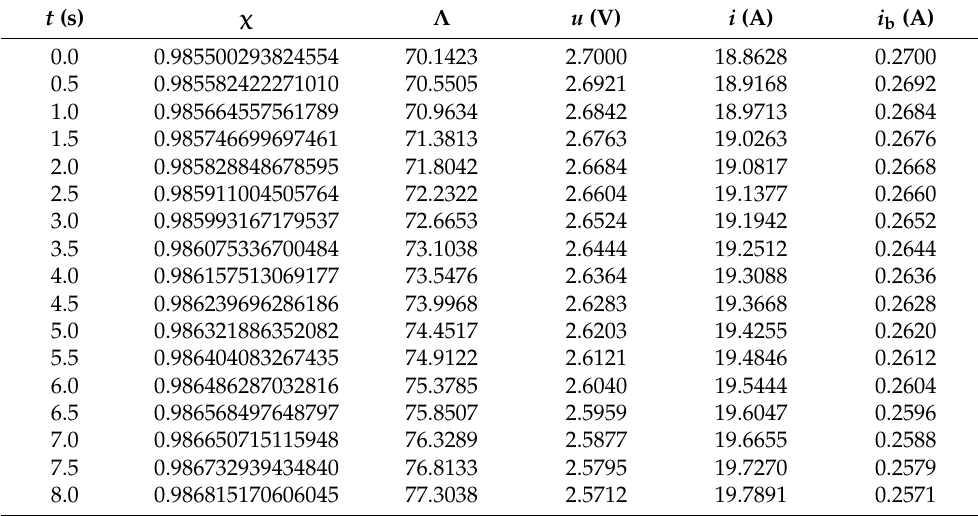
Table 2. Numerical results calculated in SC discharging, R b = 10 Ω